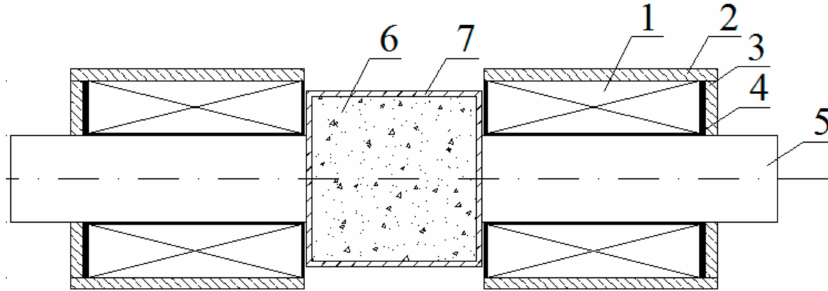
Figure 3. Magnetic vibration device. 1, Coil; 2, Shell; 3, Steel plate; 4, Coil frame; 5, Iron core; 6, Concrete; 7,